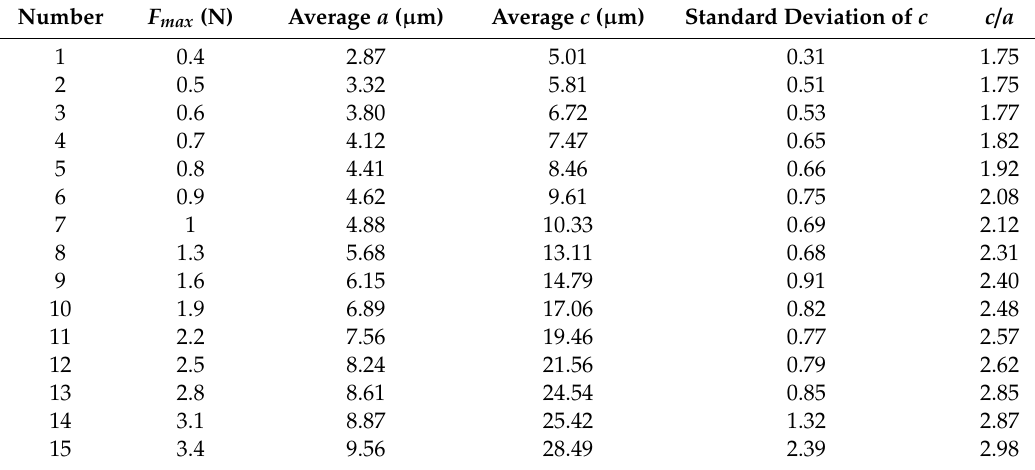
Table 3. Average indentation results of five